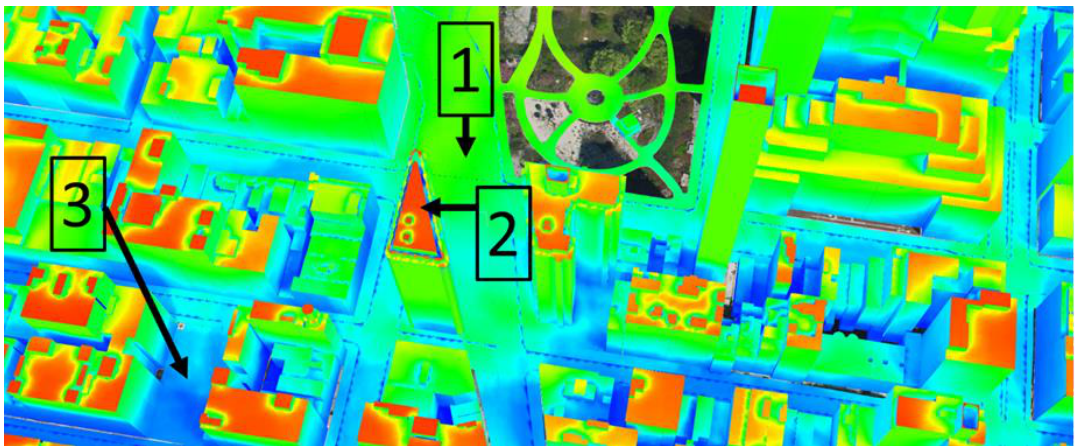
Figure 17. Visualization of a global irradiation estimation (kWh/a) for buildings and street objects Maximum Sky View Factor: (1): 0.532, (2): 0.958, (3): 0.254.